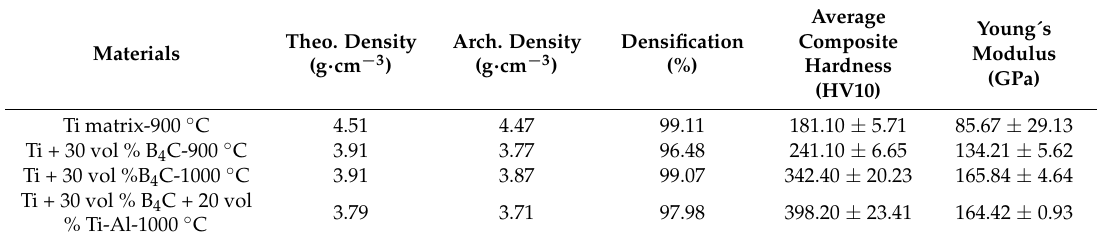
Table 2. Density, hardness and Young´s modulus of the